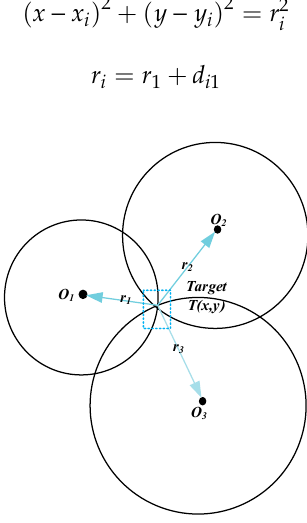
Figure 5. Basic idea of the shrinking-circle (SC) method.